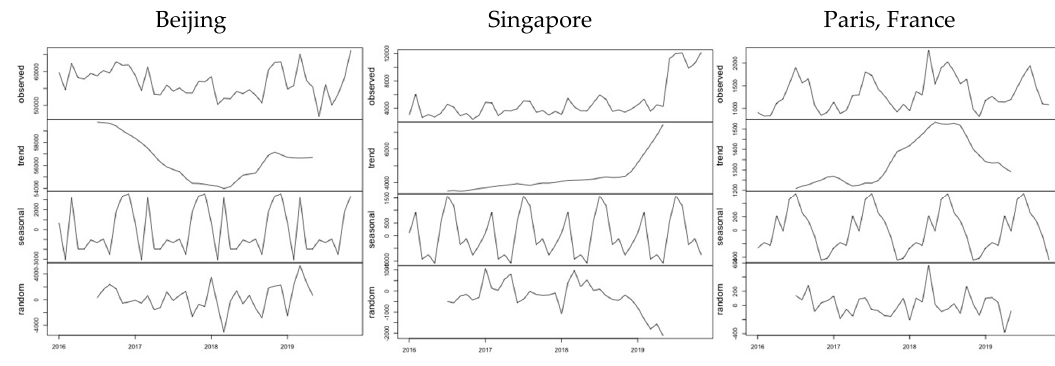
Figure 1. Example of decomposition of time series for three airports.